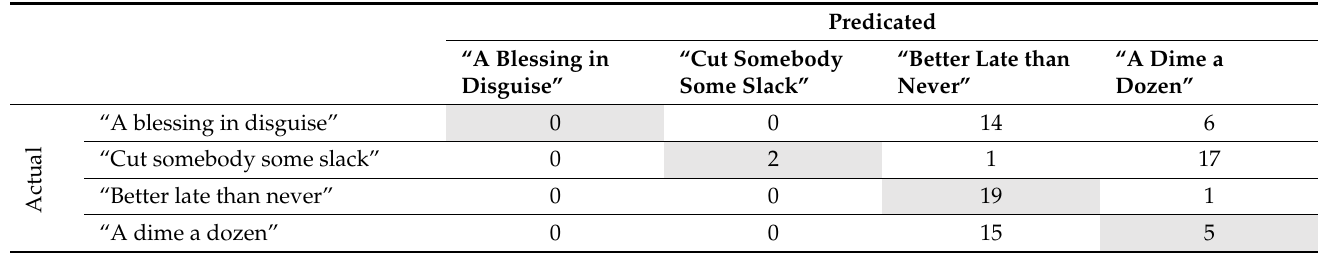
Table 8. Four-class confusion matrix for spoken phrases. Rows represent actual class and columns represent predicted